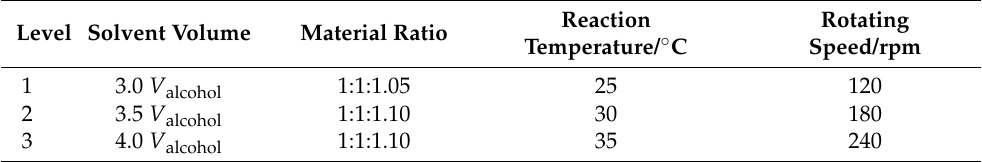
Table 1. Synthesizing orthogonal factor